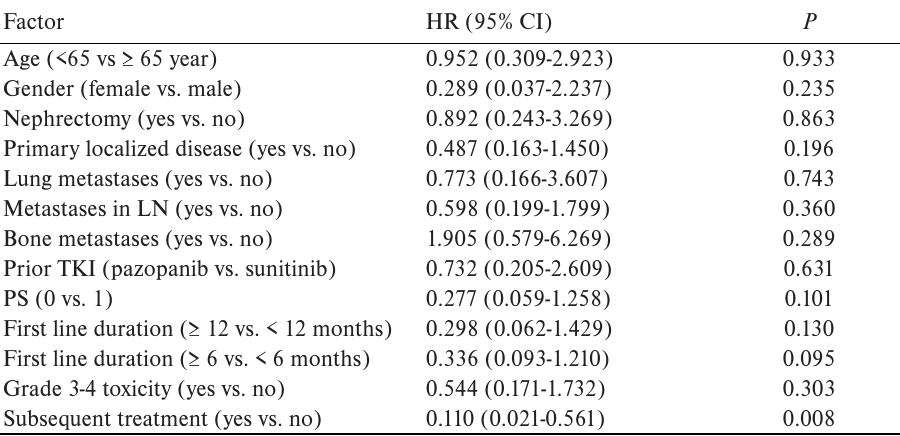
Table 3. Factor impact on overall survival.